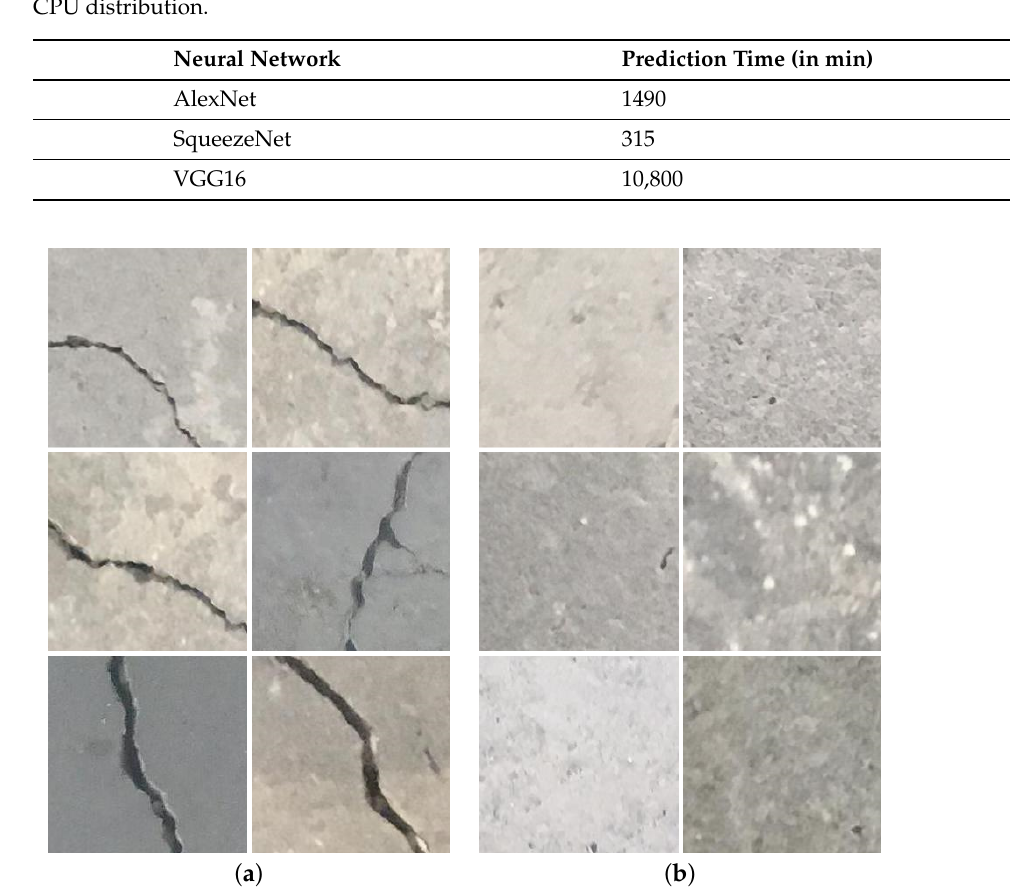
Figure 1. Sample images from the training dataset used for the concrete-crack detection. Concrete images with and without cracks are displayed in the parts ( a , b ),